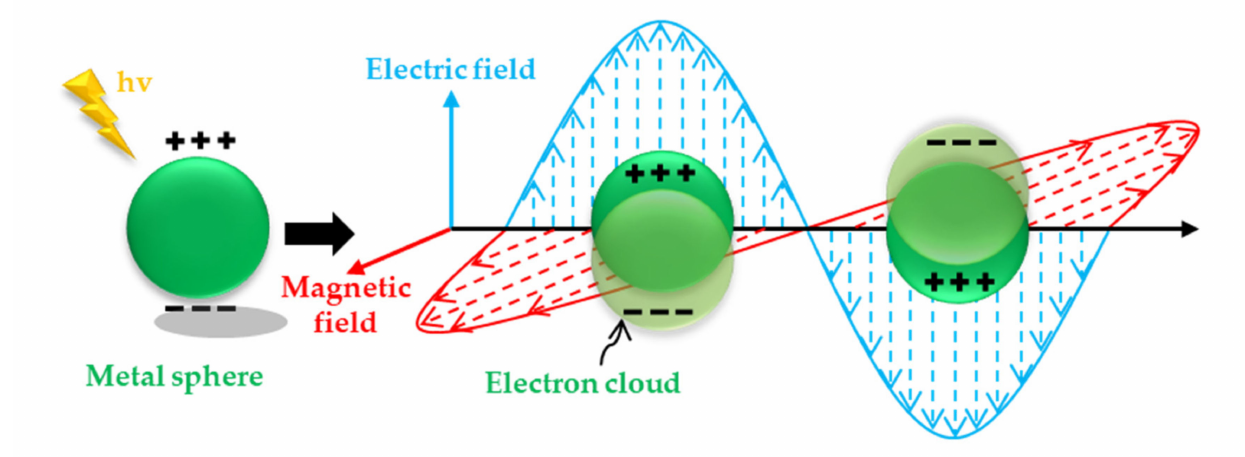
Figure 16. Schematic diagram of a localized surface